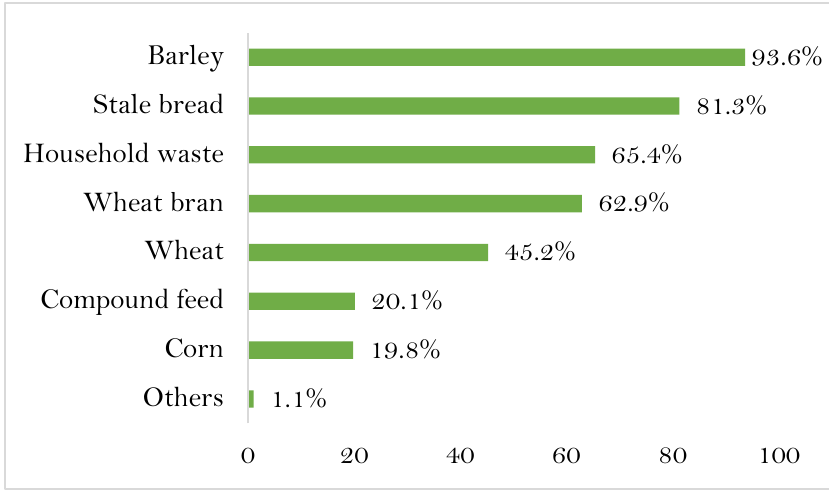
Figure 2. Main feed used for chicken feeding in percentage .